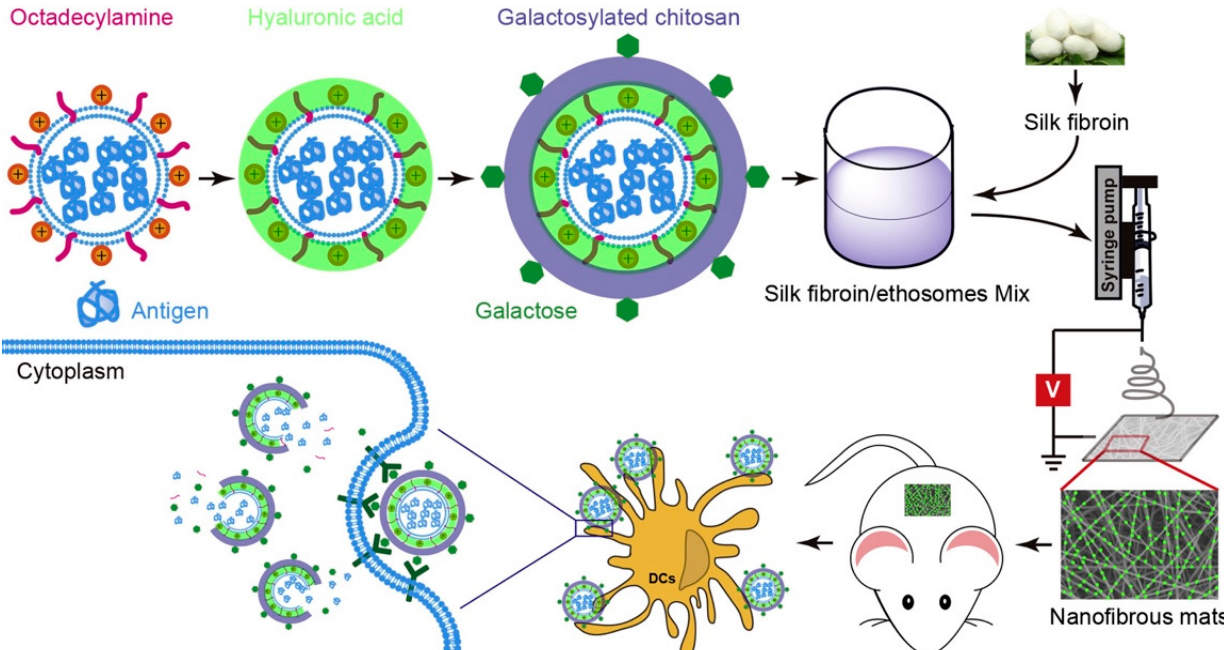
Figure 13. A schematic diagram of the preparation of the Eth-HA-GC/SF loaded OVA, causing cellular and humoral immune responses in the mouse model [187] . Reproduced with permission from Xingxing Yang, Journal of Controlled Release; published by Elsevier, 2020.